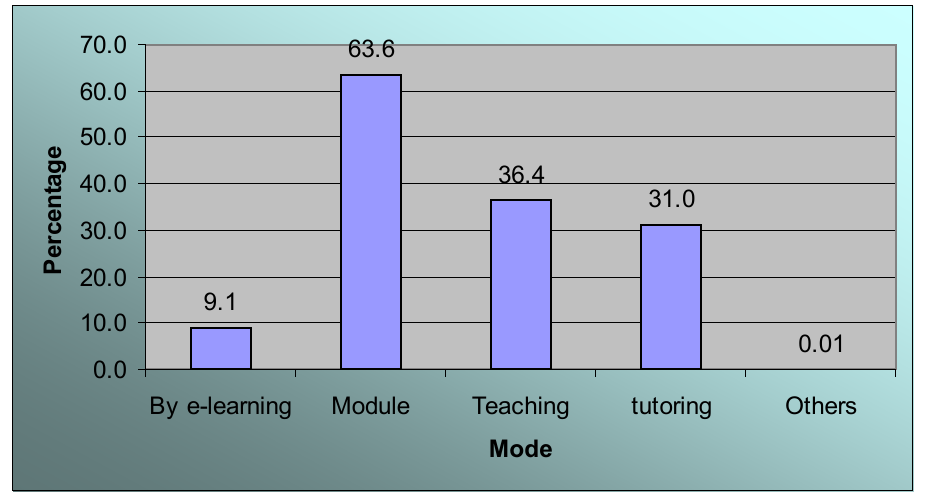
Figure 6 . Mode of receiving ILS